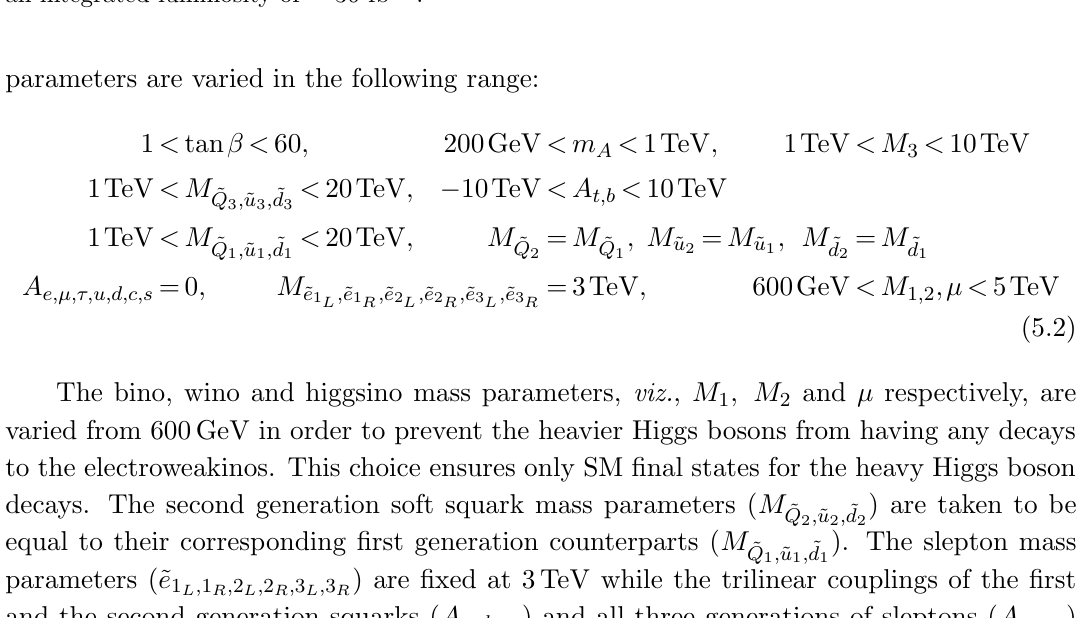
Figure 38 . Scatter plot in the m A tan (cid:12) plane showing the current status of the pMSSM (cid:0) parameter space. All parameter space points satisfy constraints from the Higgs mass measurement and the Higgs signal strengths. The grey coloured points are excluded by the latest direct search limits from (cid:27) Br ( H=A (cid:28)(cid:28) ) derived by CMS and ATLAS using the Run-II dataset with b (cid:22) bH=A (cid:2) ! an integrated luminosity of 36 fb (cid:0) 1 (cid:24)